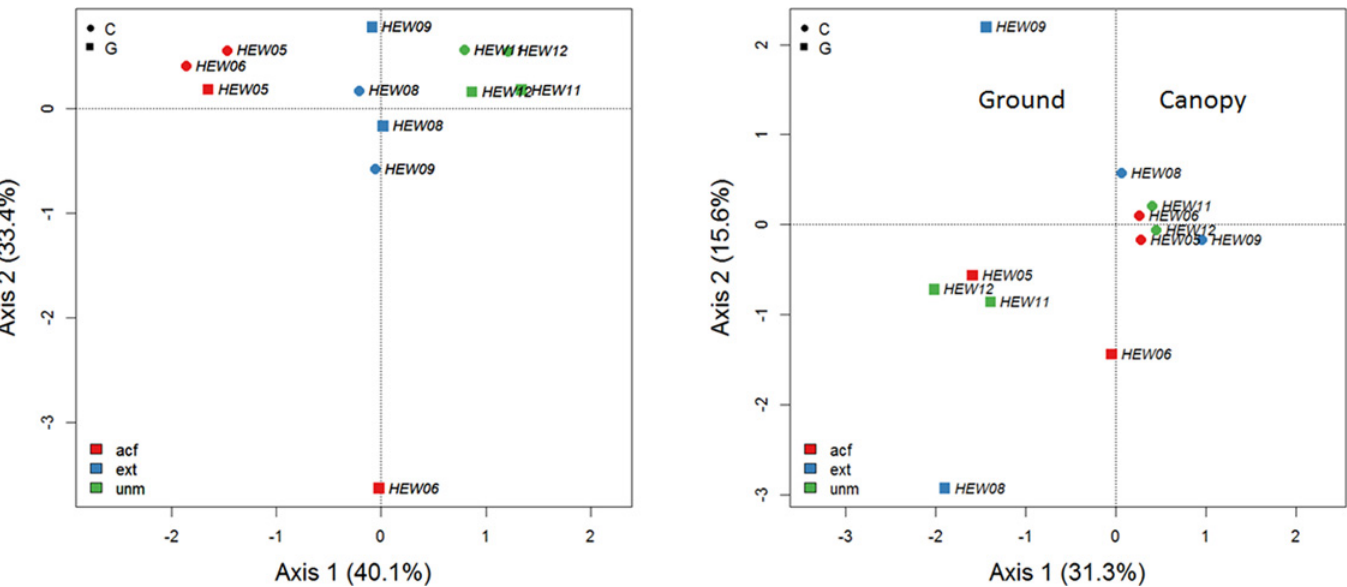
Fig 4. Ordination plots on Hainich data of all species collected at least two times (left: fungal assemblages, right: beetle assemblages). On the first axis wood-inhabiting fungi respond to forest management while FIT-sampled beetles are characterised by the factor stratum without showing a management effect; acf = age-class forest, ext = extensively managed forest, unm = unmanaged forest; C = canopy, G =